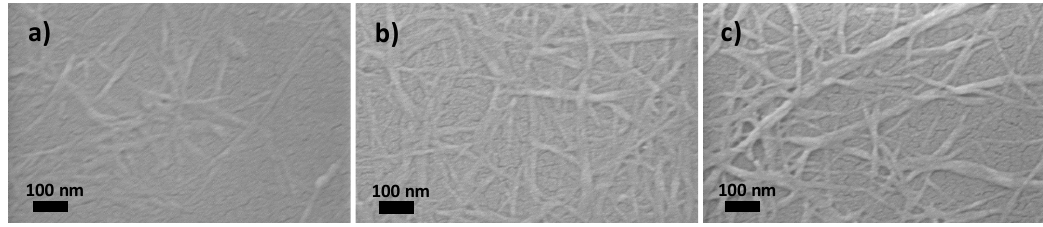
Figure 2. SEM images of dispersions of ( a ) pulp-O; ( b ) pulp-O-Br; and ( c ) pulp after 15 passes through a homogenizer.